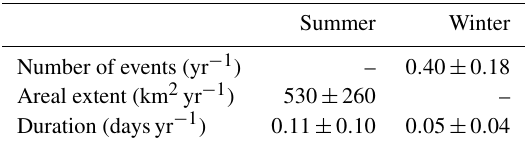
Table 2. Trends in the number of melt events, their areal extent and their duration for the period 1990–2012. The trends are de- rived from linear regressions and the uncertainties represent the 95% confidence bounds. Only trends significant at the 95% level are